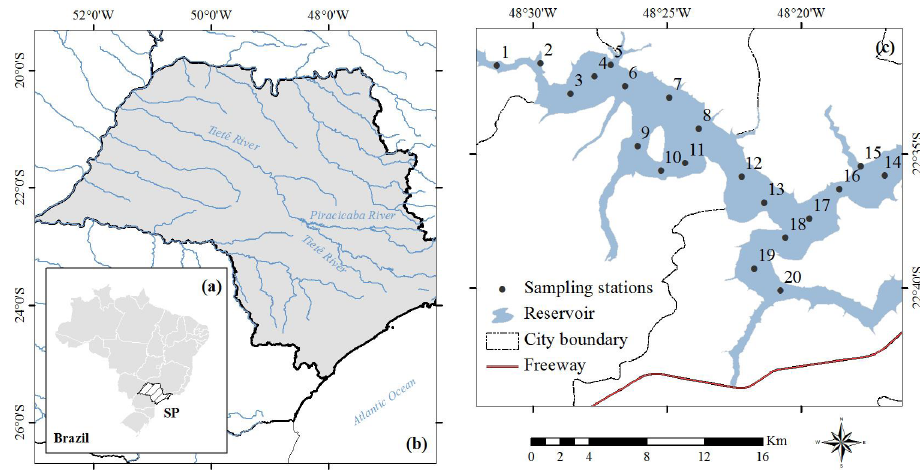
Figure 1. Barra Bonita hydroelectric reservoir and its location in Brazil and São Paulo State (highlighted) (a); cascade system in Tietê River (b); and sampling stations